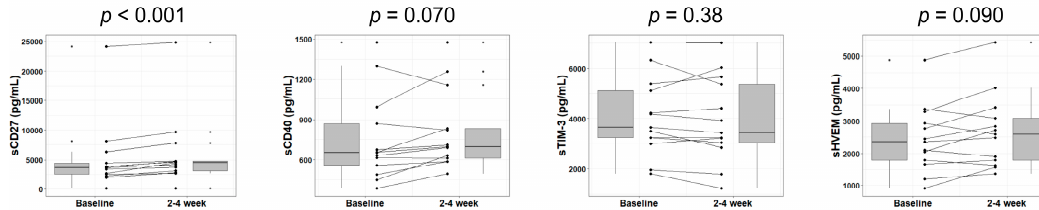
Figure 2. Changes in soluble immune checkpoint protein levels in plasma after 2 to 4 weeks of lenvatinib treatment. Box plots demonstrate the sCD27, sCD40, sTIM-3, and sHVEM levels in HCC patients at baseline and Weeks 2 through 4 of treatment. The vertical lengths of the boxes indicate the interquartile ranges and the lines in the boxes display the median values, while the error bars show the minimum and maximum values (in a range). The Wilcoxon signed-rank test was used.